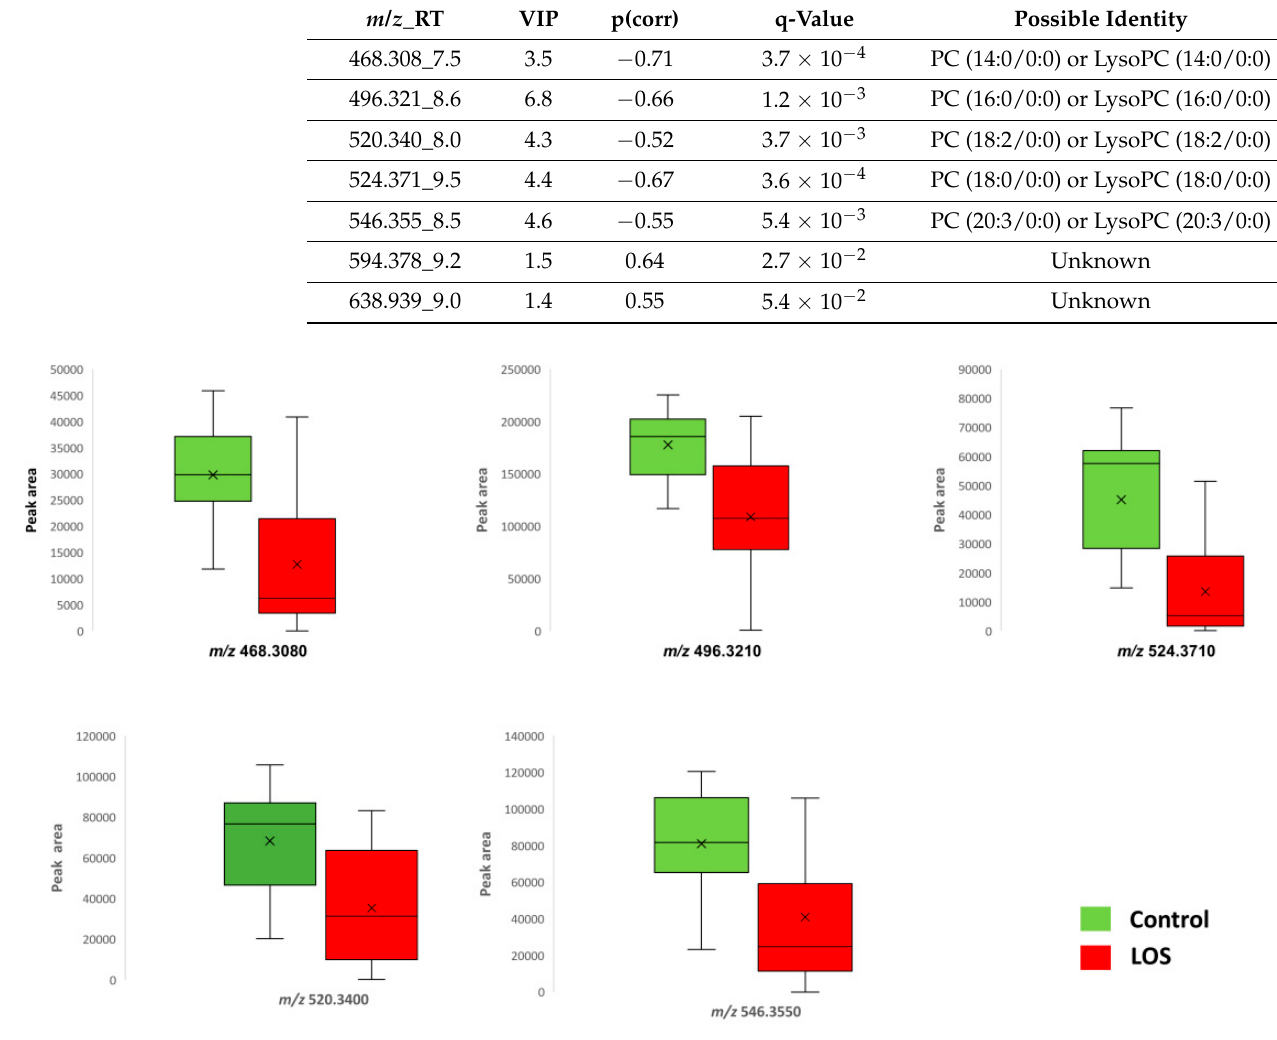
Figure 2. Box plots of significant metabolites in the control and late-onset (LOS) groups.